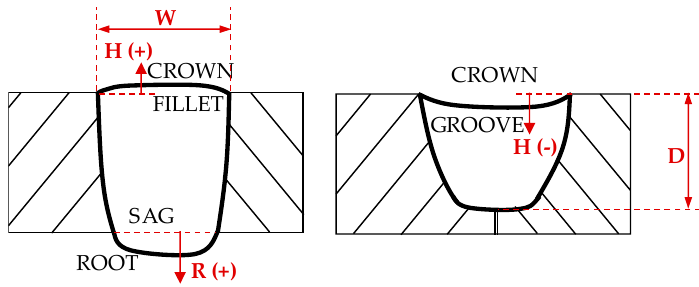
Figure 10. Scheme of the different cross sections of the weld bead (W: crown width; H: crown height; R: root height; D: penetration depth).